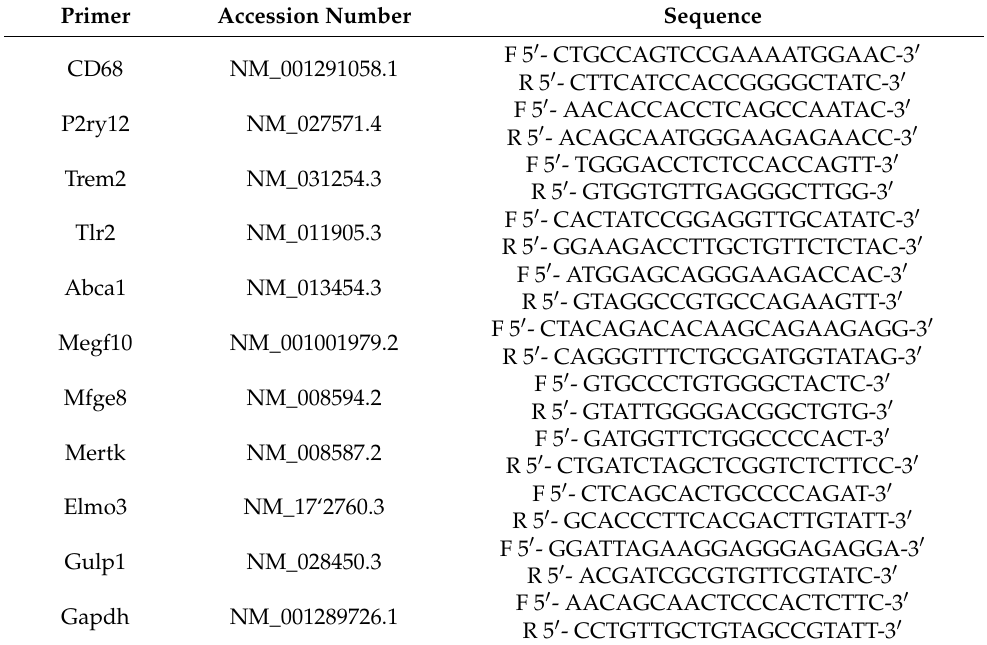
Table 1. Primer sequences for